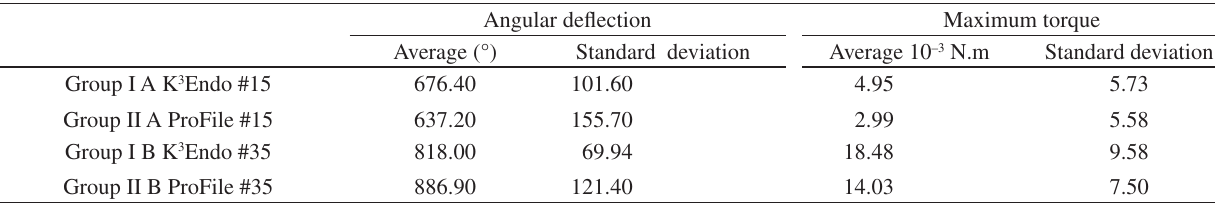
Figure 2. Image close to the instrument during the Table 1. Average and standard deviation values of the angular deflection and maximum torque.